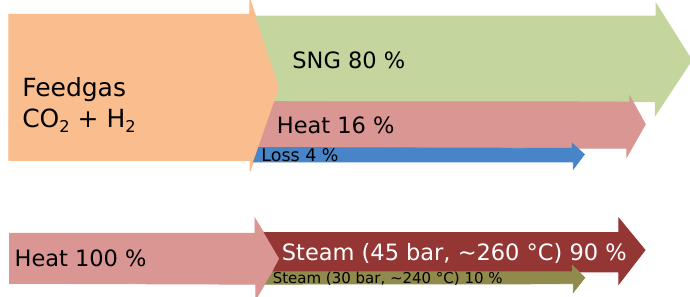
Figure 3. Sankey diagram of a tubular bundle methanation reactor